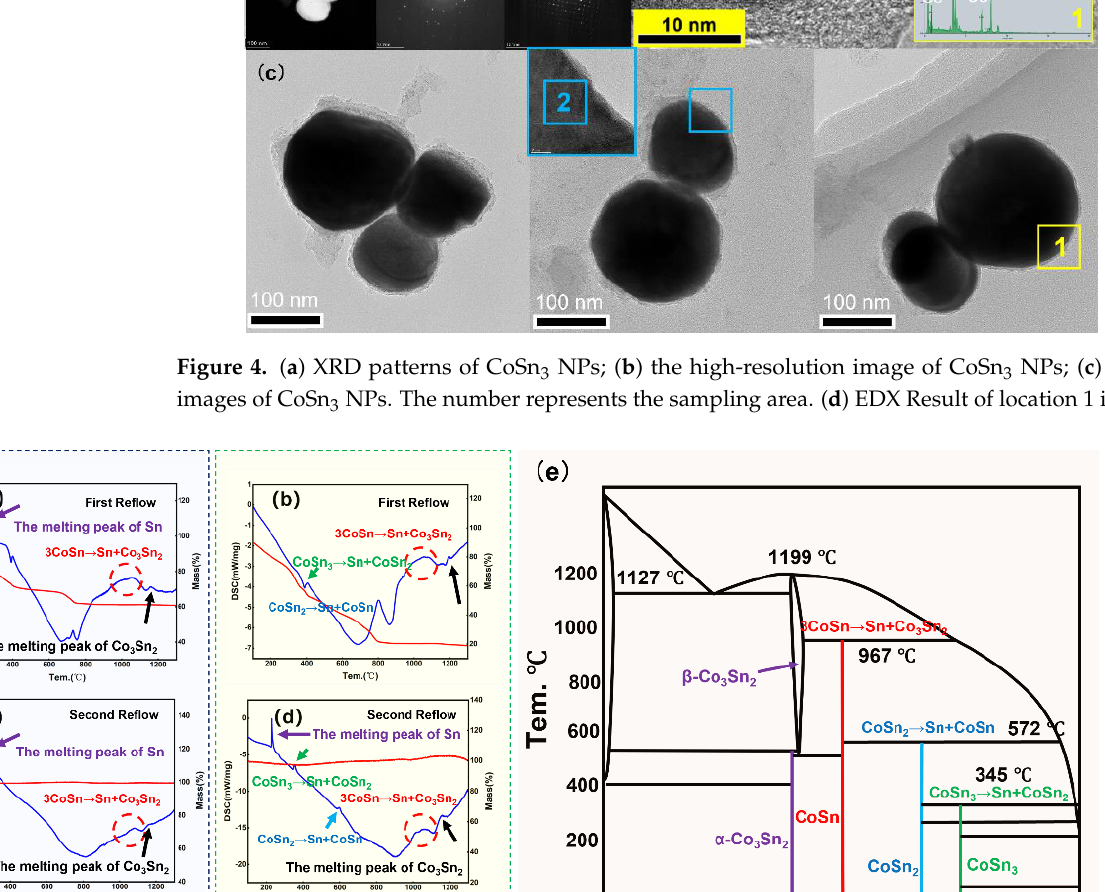
Figure 5. Results of DSC-TG experiments. ( a ) First DSC-TG experiment of pellets obtained by drying samples after reduction sonication; ( b ) first DSC-TG experiment of samples heated in a tube furnace for 15 min; ( c ) second DSC-TG experiment of pellets obtained by drying samples after reduction sonication; ( d ) second DSC-TG experiment of pellets obtained by drying samples after reduction sonication; ( e ) Co – Sn binary phase diagram.